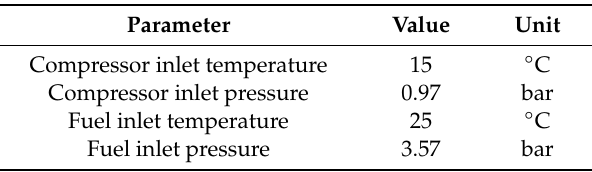
Table 1. The boundary conditions of MGT.